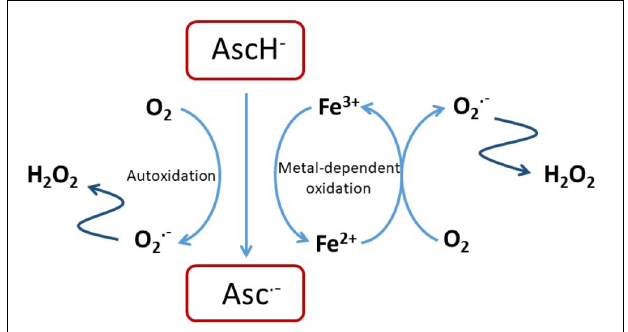
FIGURE 1 | Pro-oxidant activity of ascorbate. Reactions of ascorbate with oxygen or free transition metal ions such as Fe 2 + / 3 + or Cu + / 2 + can result in the generation of H 2 O 2 that is itself cytotoxic of that can undergo further reaction to exacerbate oxidative stress (Shah et al., 2009; Vissers et al., 2011; Nualart et al.,